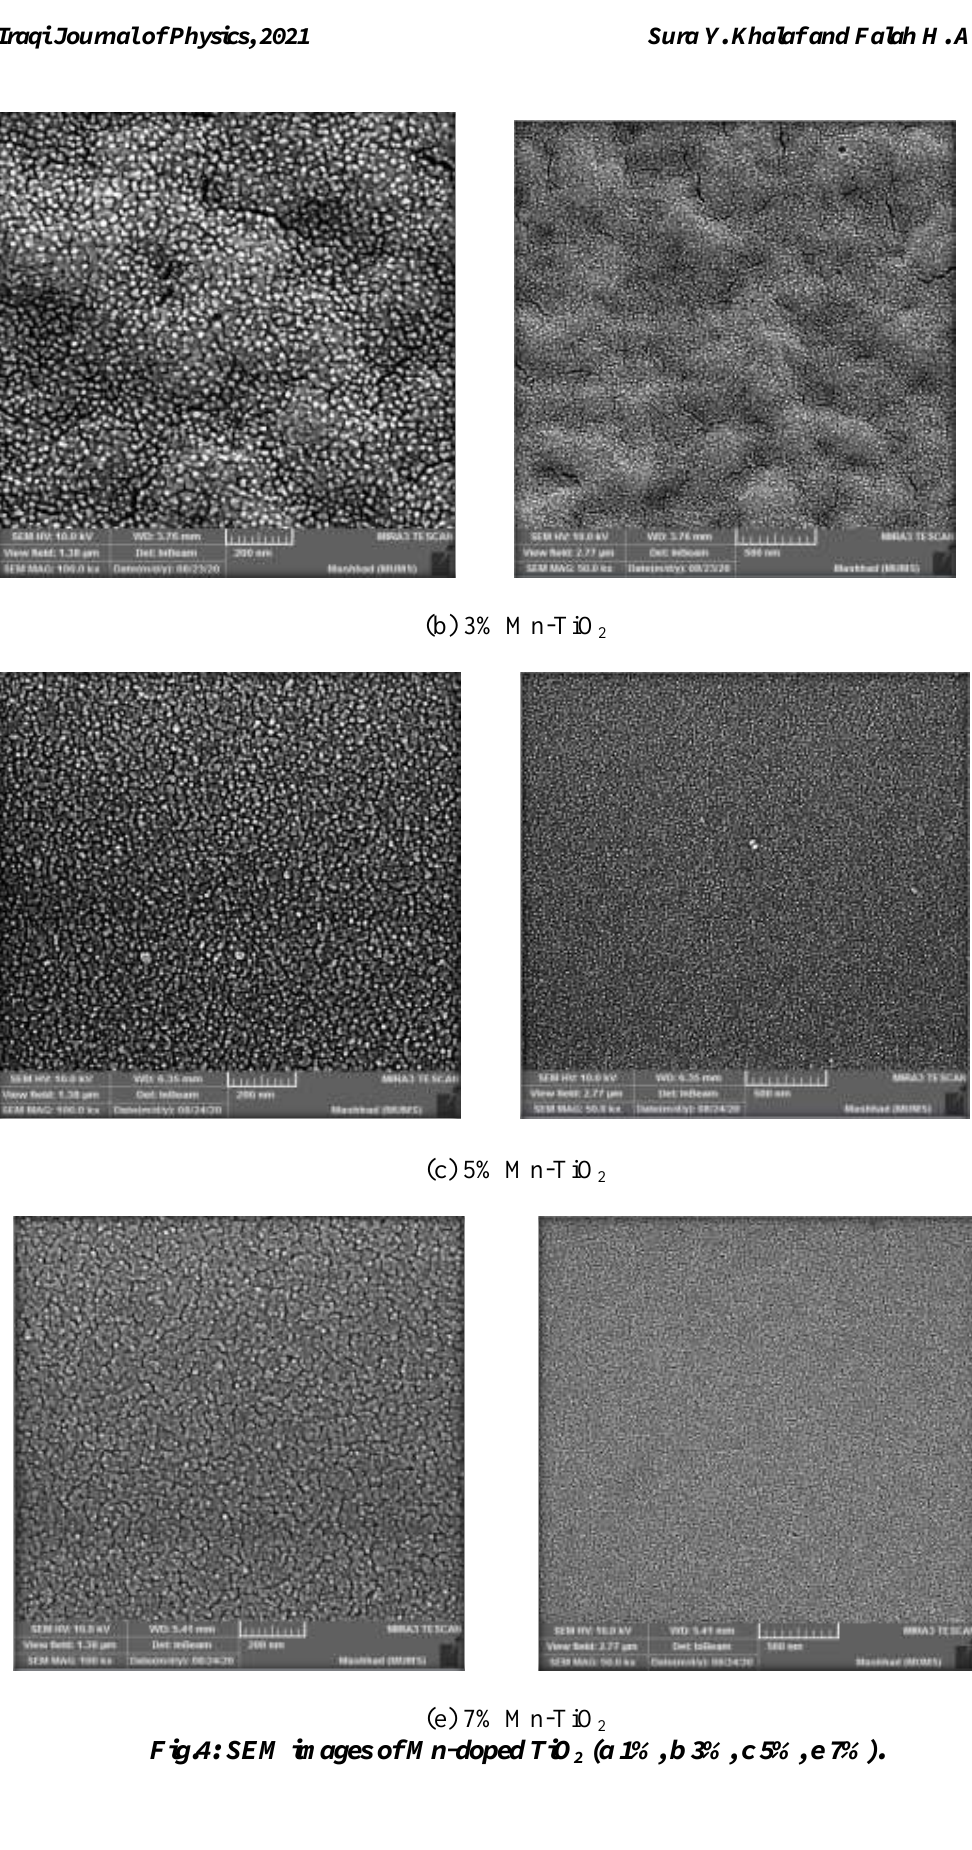
(a 1%, b 3%, c 5%, e 2